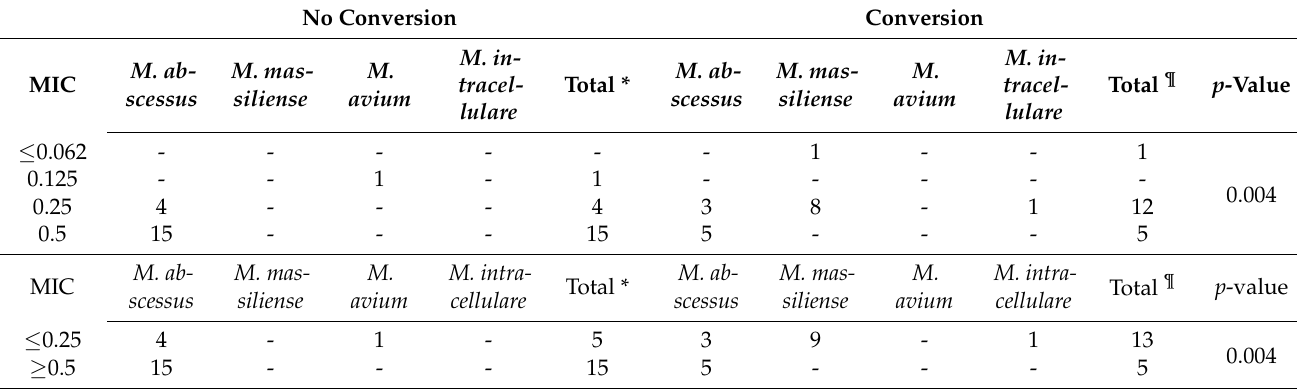
Table 4. Culture conversion rate after 12 months of treatment in patients without drug-resistant isolates according to MIC value and NTM species ( n =